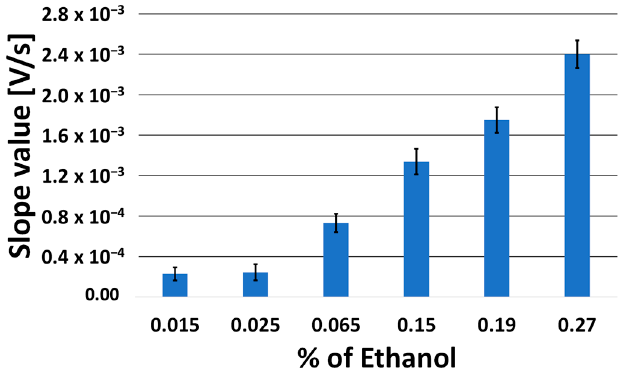
Figure 7. Bar chart diagram of the slope values of the tangent line at the point of maximum slope to the obtained voltage–charge curves, using catalase crosslinked with LDHs (1:1.5 by weight) and H 2 O 2 (12 mmol L − 1 ) in solution at different increasing ethanol percentages in the hydroalcoholic solutions tested.